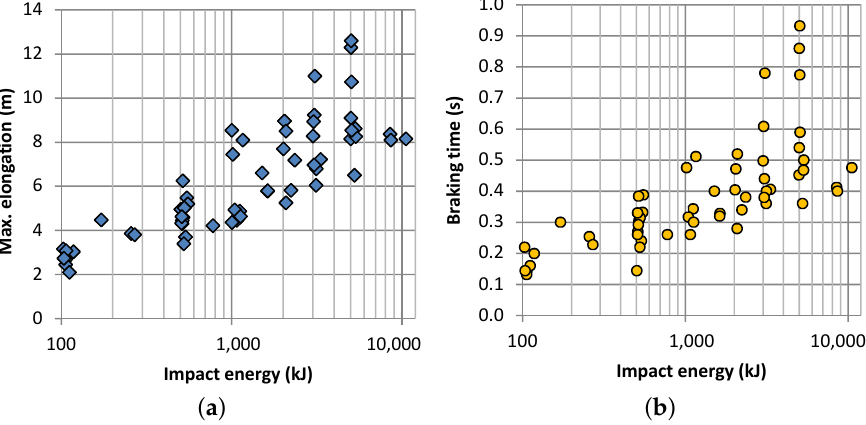
Figure 6. Braking distance and braking time as a function of impact energy of the MEL